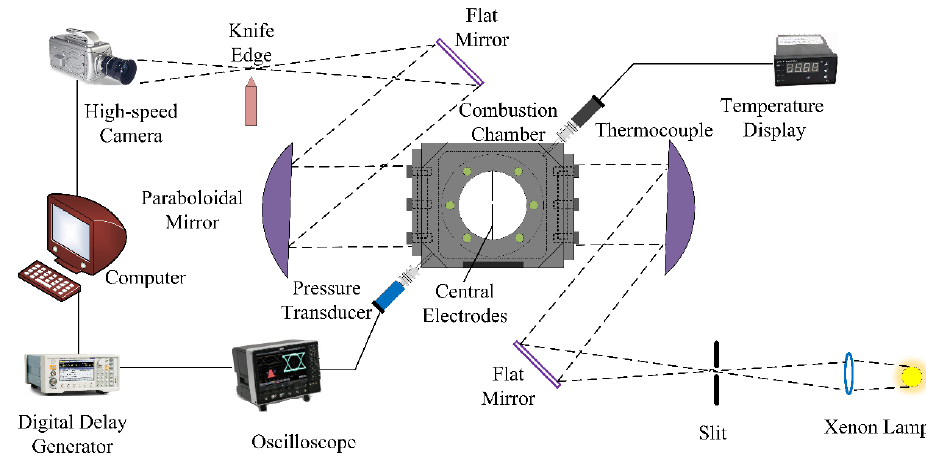
Figure 1. The system of the experimental set-up. Table 1. Fuels with different components tested in this study. Fuel Fuel Group